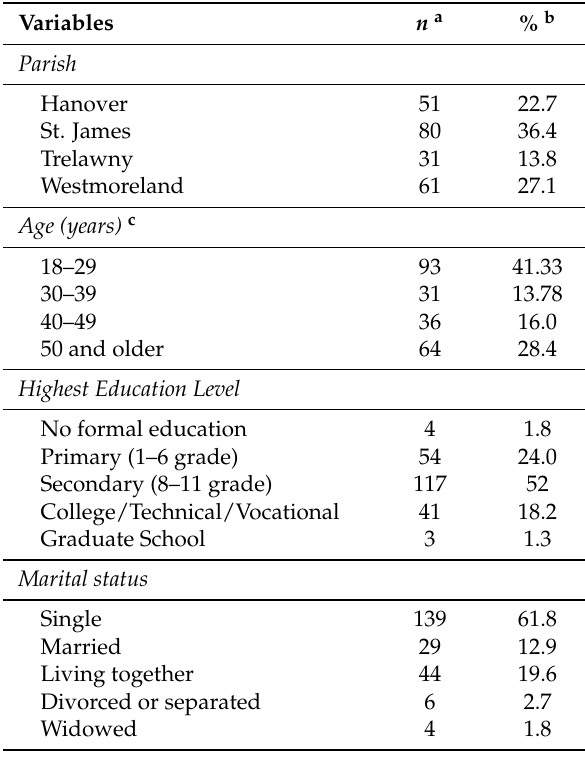
Table 1. Sociodemographic characteristics of intervention participants ( n =